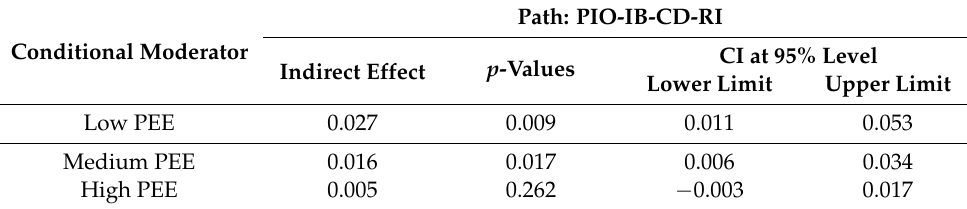
Table 6. The analysis of moderated chain mediation